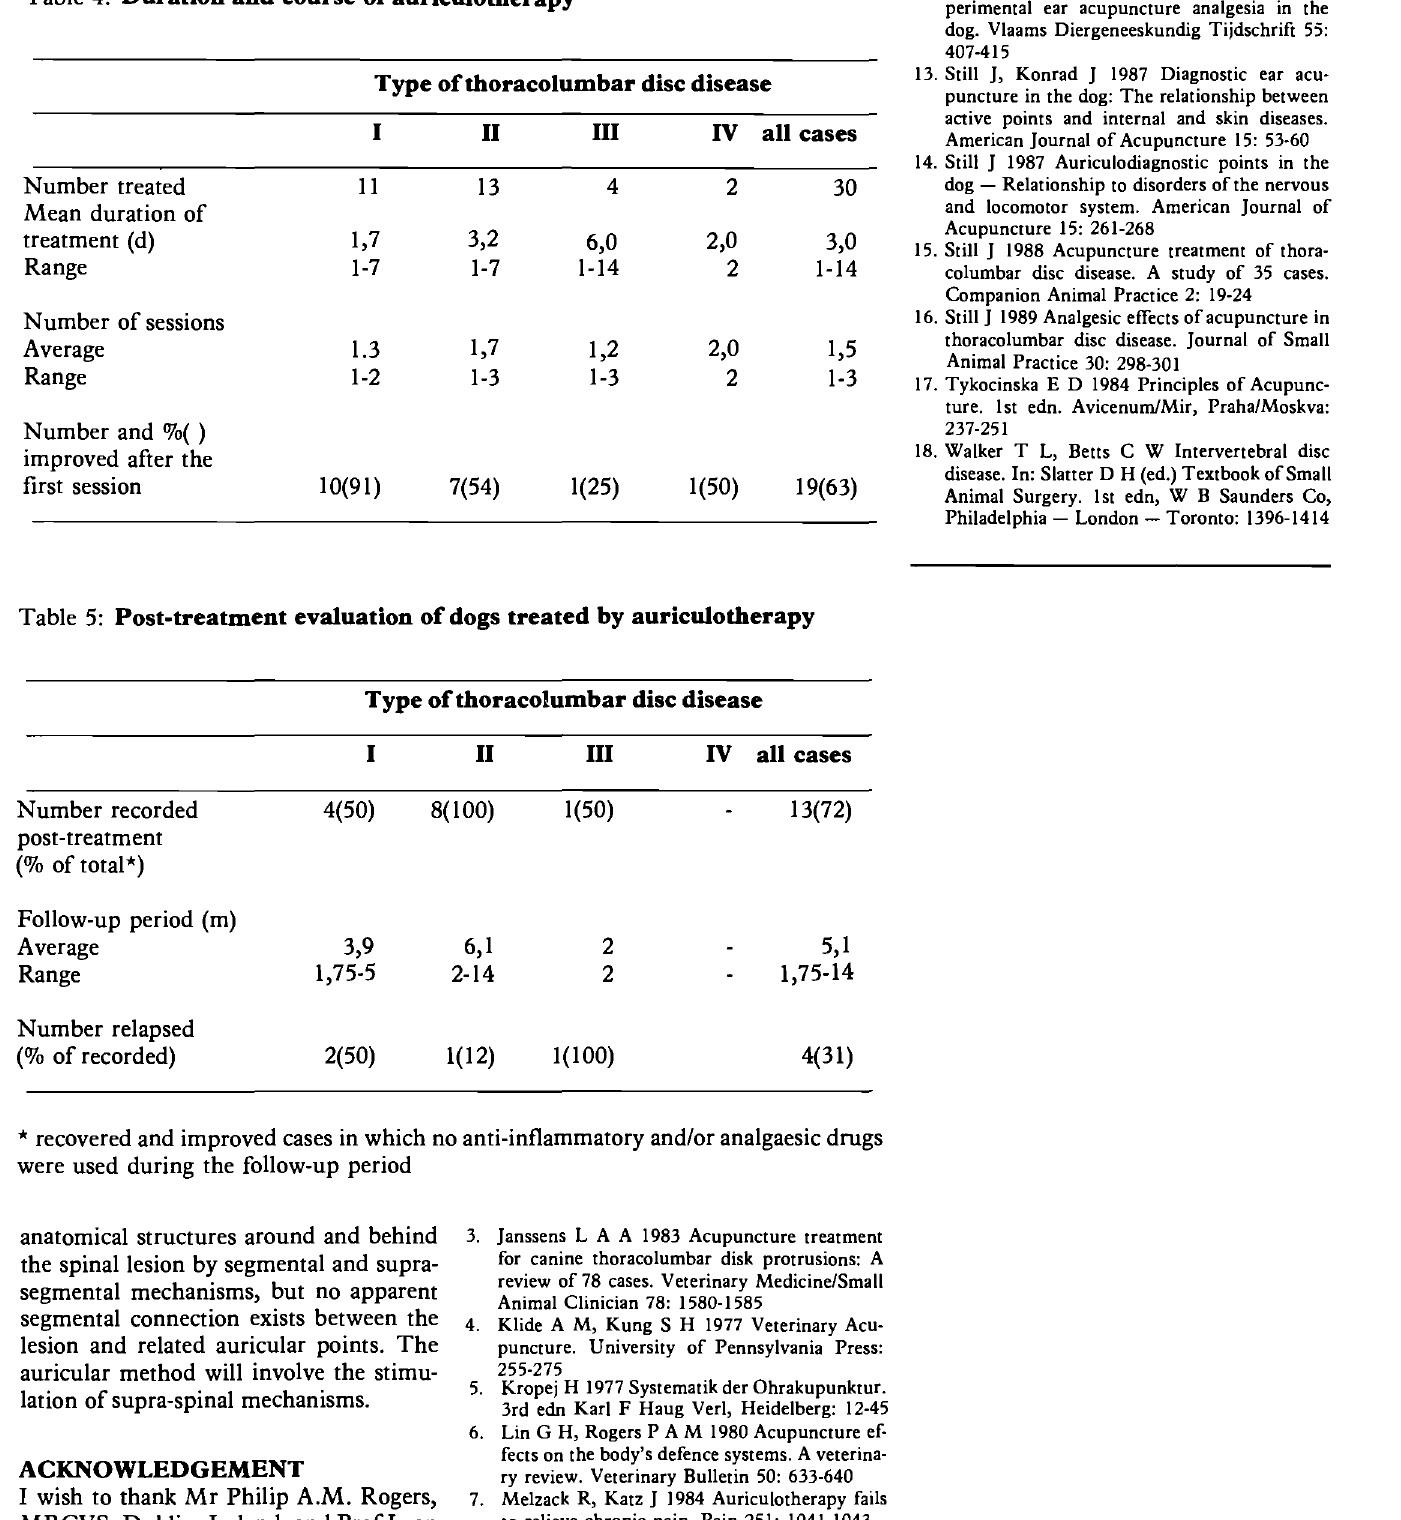
Table 4: Duration and course of auriculotherapy